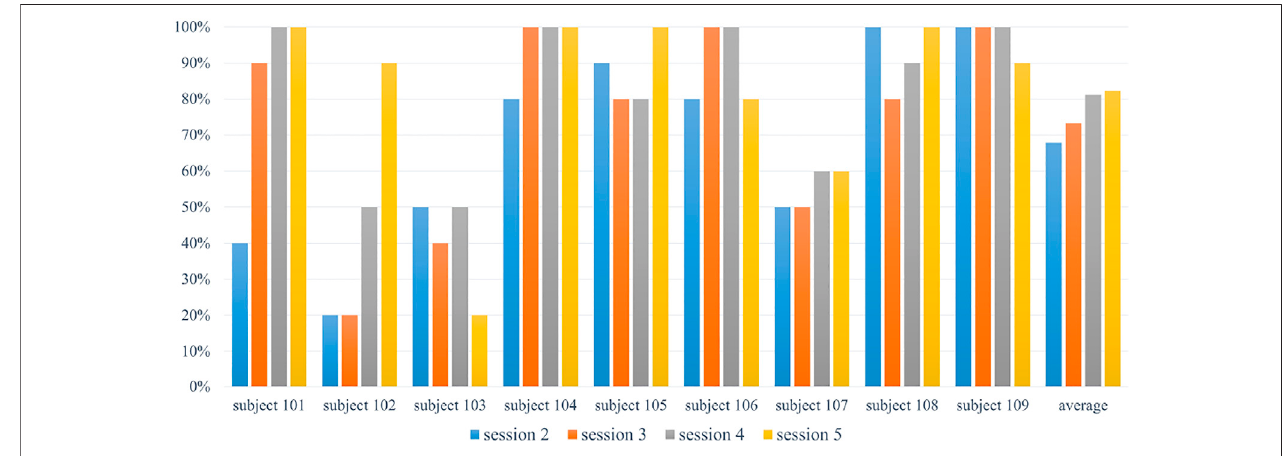
FIGURE 9 | Motor control accuracy result.